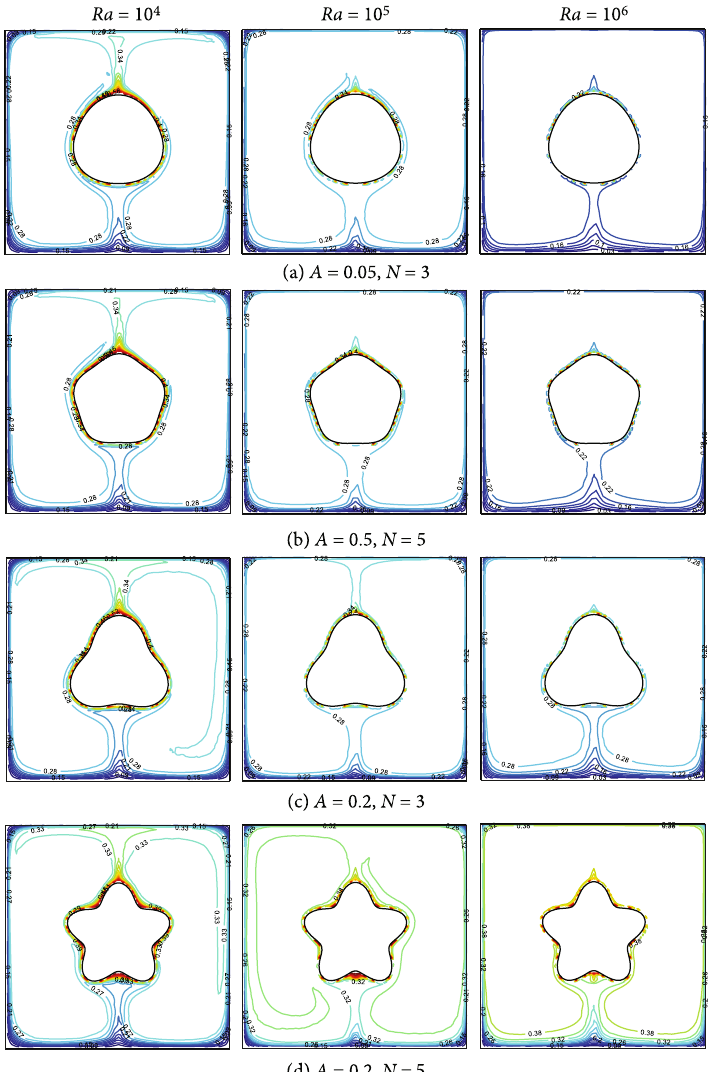
Figure 7: Alumina distribution for combination values of Rayleigh numbers and corrugation amplitude, A , and number, N , at ϕ = 0 : 03